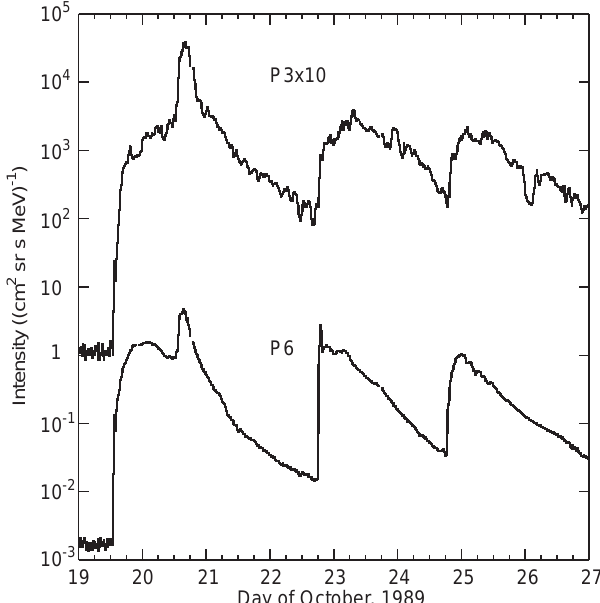
Fig. 1. GOES-6 proton observations of the 19–27 October